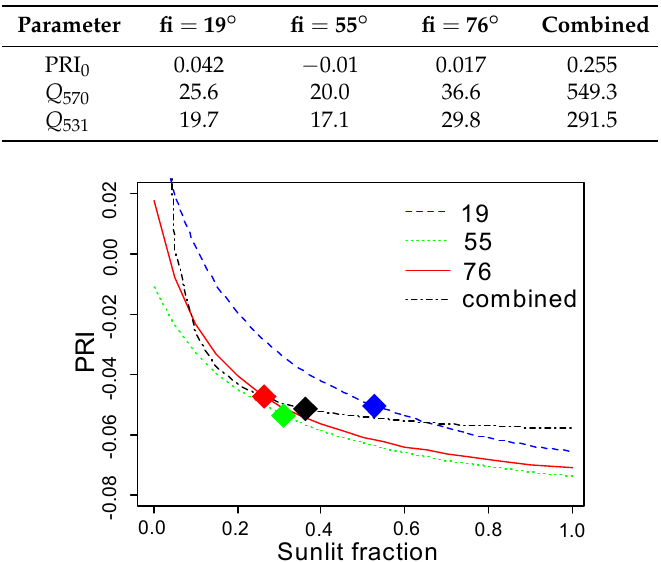
Figure 11. Fitted PRI vs sunlit fraction curves for β = 19 ◦ , β = 55 ◦ , and β = 76 ◦ . Symbols denote the location of the mean sunlit fraction for each scatter angle.